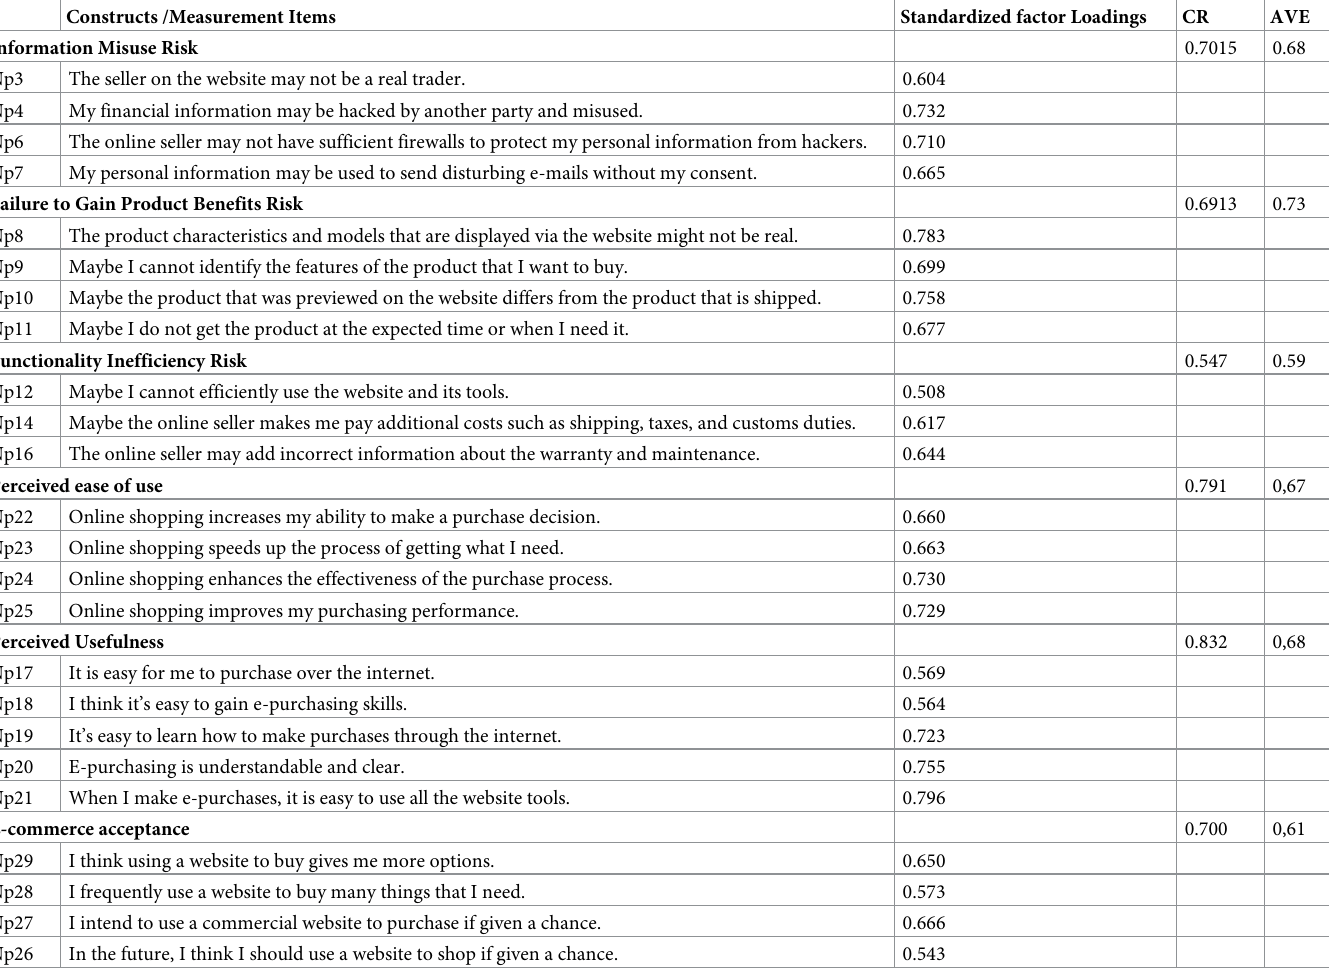
Table 2. Reliability and factor